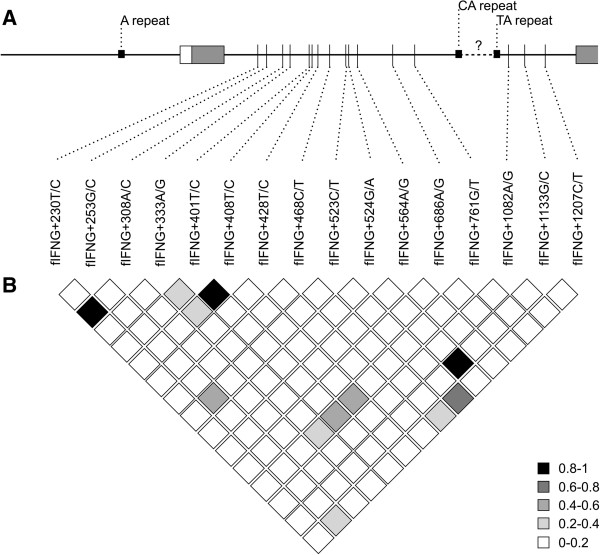
A schematic of the partial fIFNG sequences analyzed in this study. (A) A partial fIFNG sequence of 2067 bp was sequenced in this study, including the 5′ proximal regulatory region, 5′ UTR, exon 1, intron 1 and a partial exon 2 region. Black box: repeat region. White box: 5′ UTR. Gray boxes: exons 1 and 2. ?: a ~115 bp region between 2 repeat regions of unknown sequence. (B) LD plot of the 16 SNP tested in this study. The r2 values between different SNP are indicated by different colors.